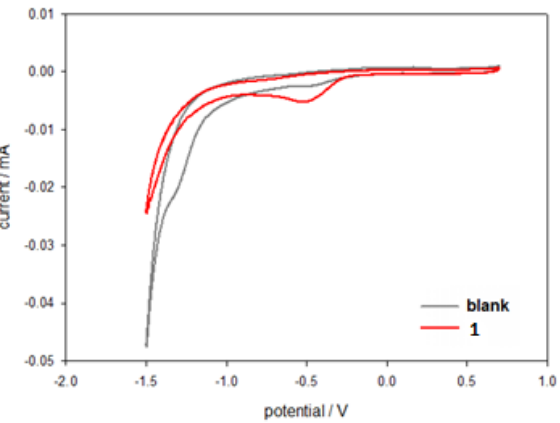
Figure 5. Cyclic voltammogram of 1 recorded with a glassy carbon electrode in an aqueous solution (5 × 10 − 4 M phosphate buffer, pH = 7.4). Scan rate 20 mVs − 1 .